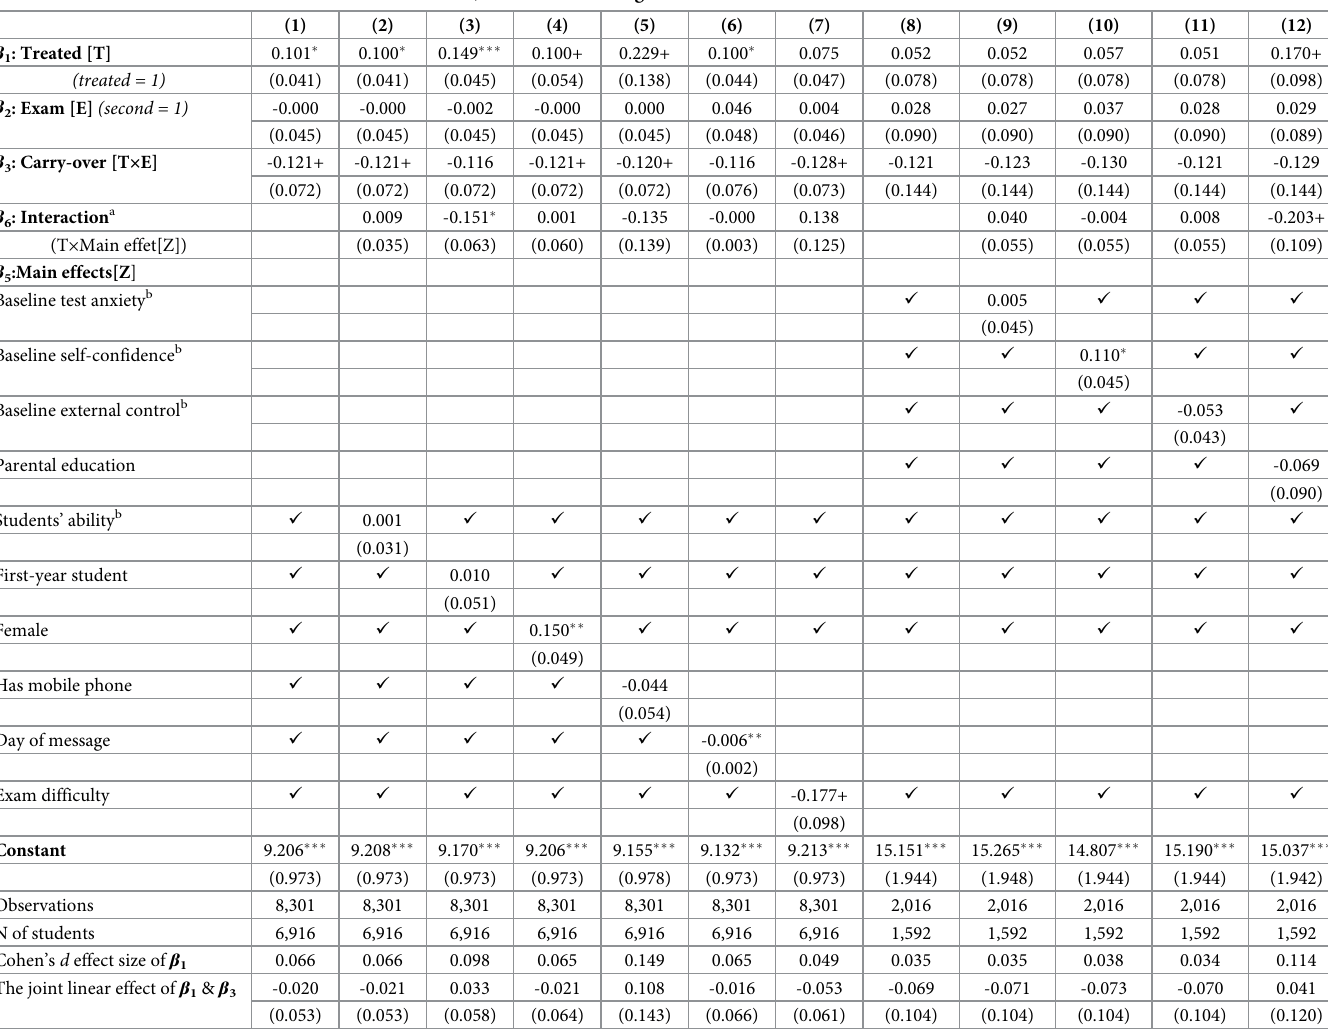
Table 4. Treatment effect on students’ endline motivation, unstandardized regression